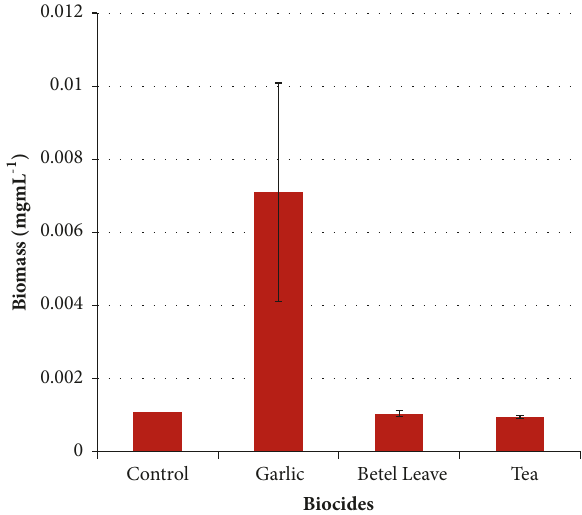
Figure 4: Effects of biocides (garlic, betel leave and tea) at concen- tration of 90 mgmL −1 on the overall biomass weight collected after 7 th days of incubation.